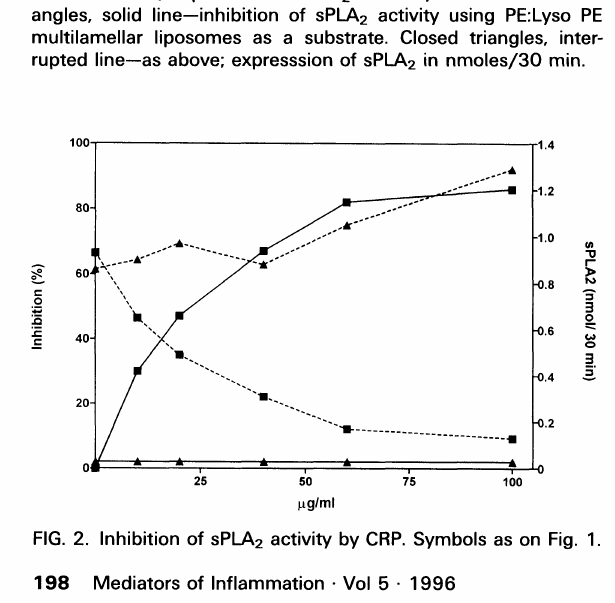
FIG. 4. Comparison of inhibitory activity of lactoferrin (squares), SAP (triangles) and CRP (circles) against sPLA2, expressed in micromolar concentrations. PC:Lyso PC multilamellar liposomes used as a substrate.